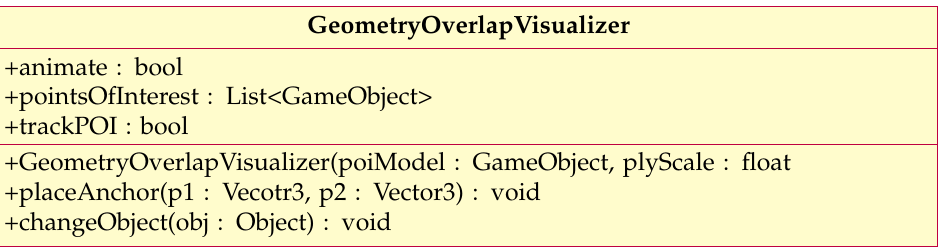
Figure 9. Class diagram of the GeometryOverlapVisualizer with all relevant functions and fields. Figure 10a,b show the results using a real decanter and the CAD counterpart.